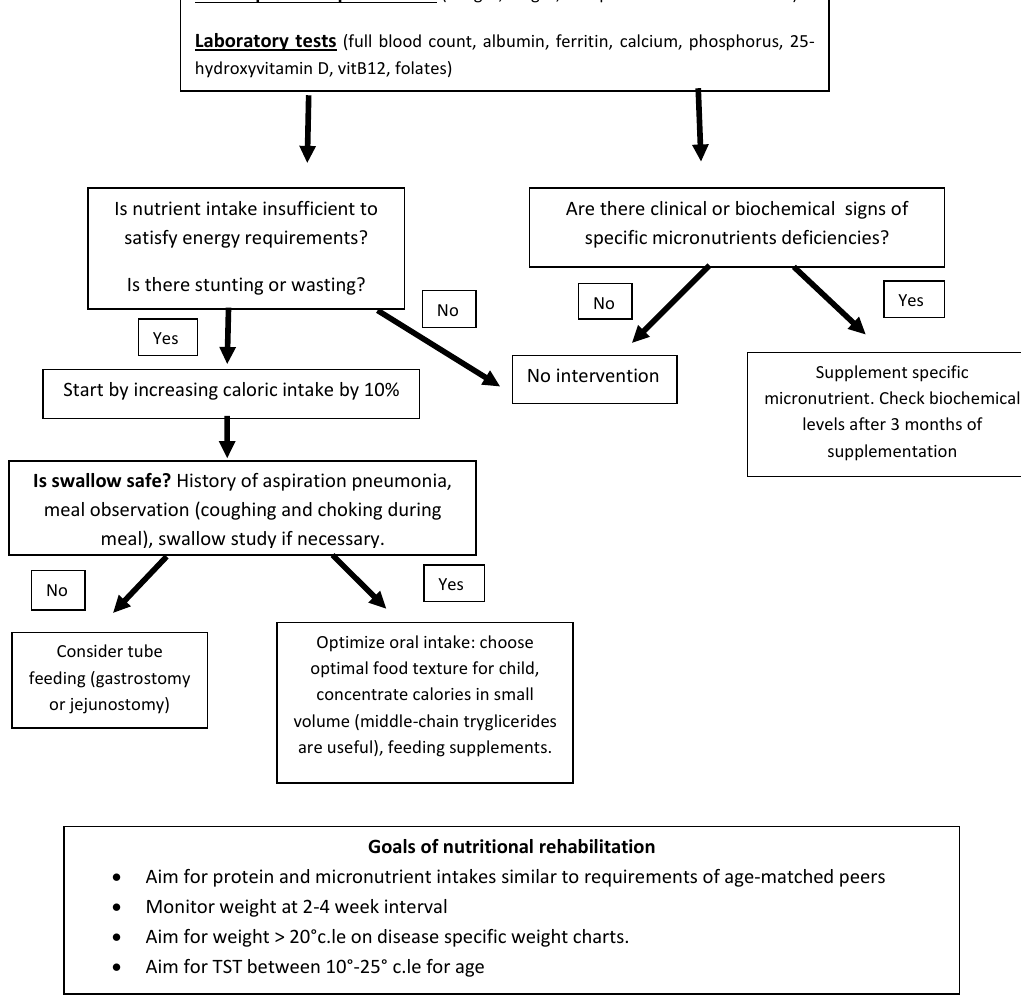
Figure 1. Proposed approach for nutritional assessment and intervention in NI